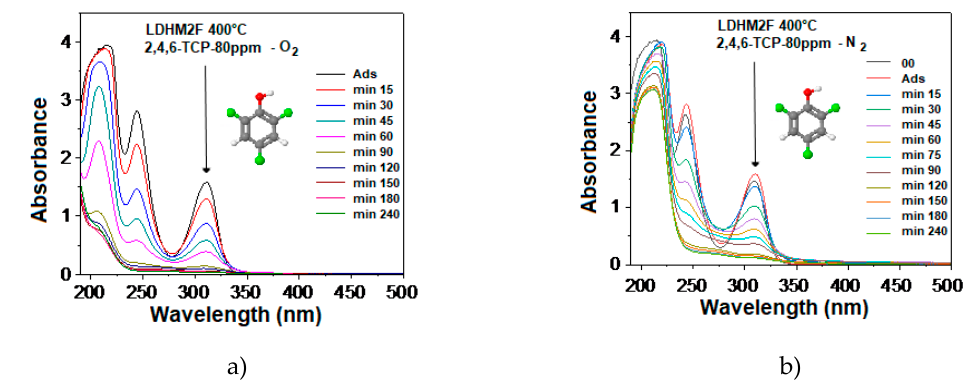
Figure 13. UV-Vis spectra in the photodegradation of 246-trichlorophenol in ( a ) the presence and ( b ) the absence of oxygen.